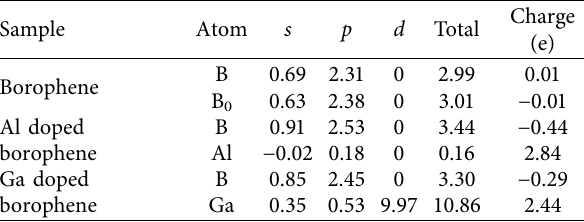
Table 2: Mulliken population analysis of atoms around the im- purity atom.